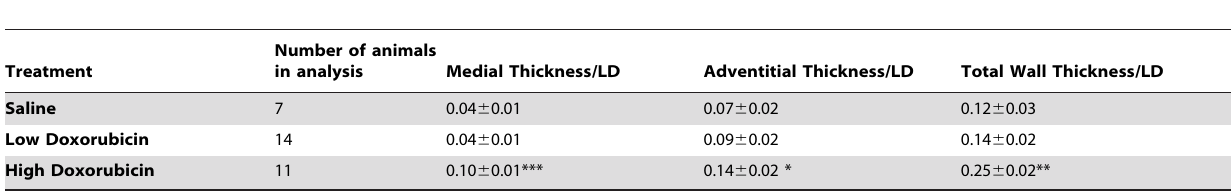
Table 3. Effect of Doxorubicin (DOX) on coronary artery medial thickness, adventitial thickness and total wall thickness: normalized to lumen